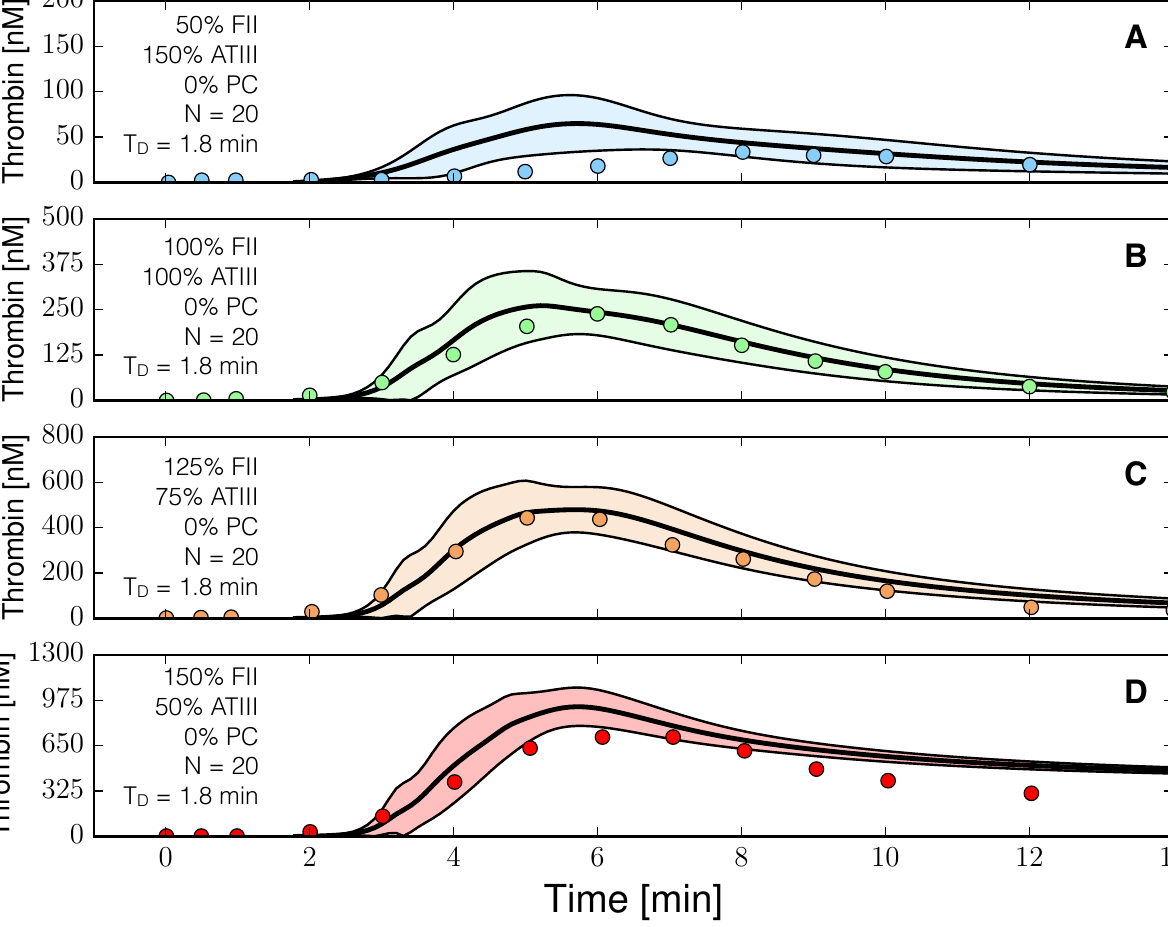
Figure 5. Reduced order coagulation model predictions versus experimental data for normal coagulation. The reduced order coagulation model parameter estimates were tested against data not used during model training. Simulations of different levels of prothrombin and ATIII were compared with experimental data in the absence of the protein C pathway. Solid lines denote the simulated mean value of the thrombin profile for N = 20 independent particles, points denote experimental data. The shaded region denotes the 99% confidence estimate of the mean simulated thrombin value (uncertainty in the model simulation). ( A – D ) prediction results for (FII,ATIII): (50%, 150%), (100%, 100%), (125%, 75%) and (150%,50%) of physiological prothrombin and ATIII levels in the absence of the protein C pathway. The experimental validation data was reproduced from the study of Butenas et al. [40]. Thrombin generation in these experiments was initiated using 5 pmol/L FVIIa-TF in the presence of 200 µ mol/L of phospholipid vesicles (PCPS). As depicted in ( A – D ) the prothrombin and ATIII levels were at (50%, 150%), (100%, 100%), (125%, 75%) and (150%, 50%) of their physiological concentrations in the absence of protein C pathway. All factors and control proteins were at their physiological concentration unless otherswise